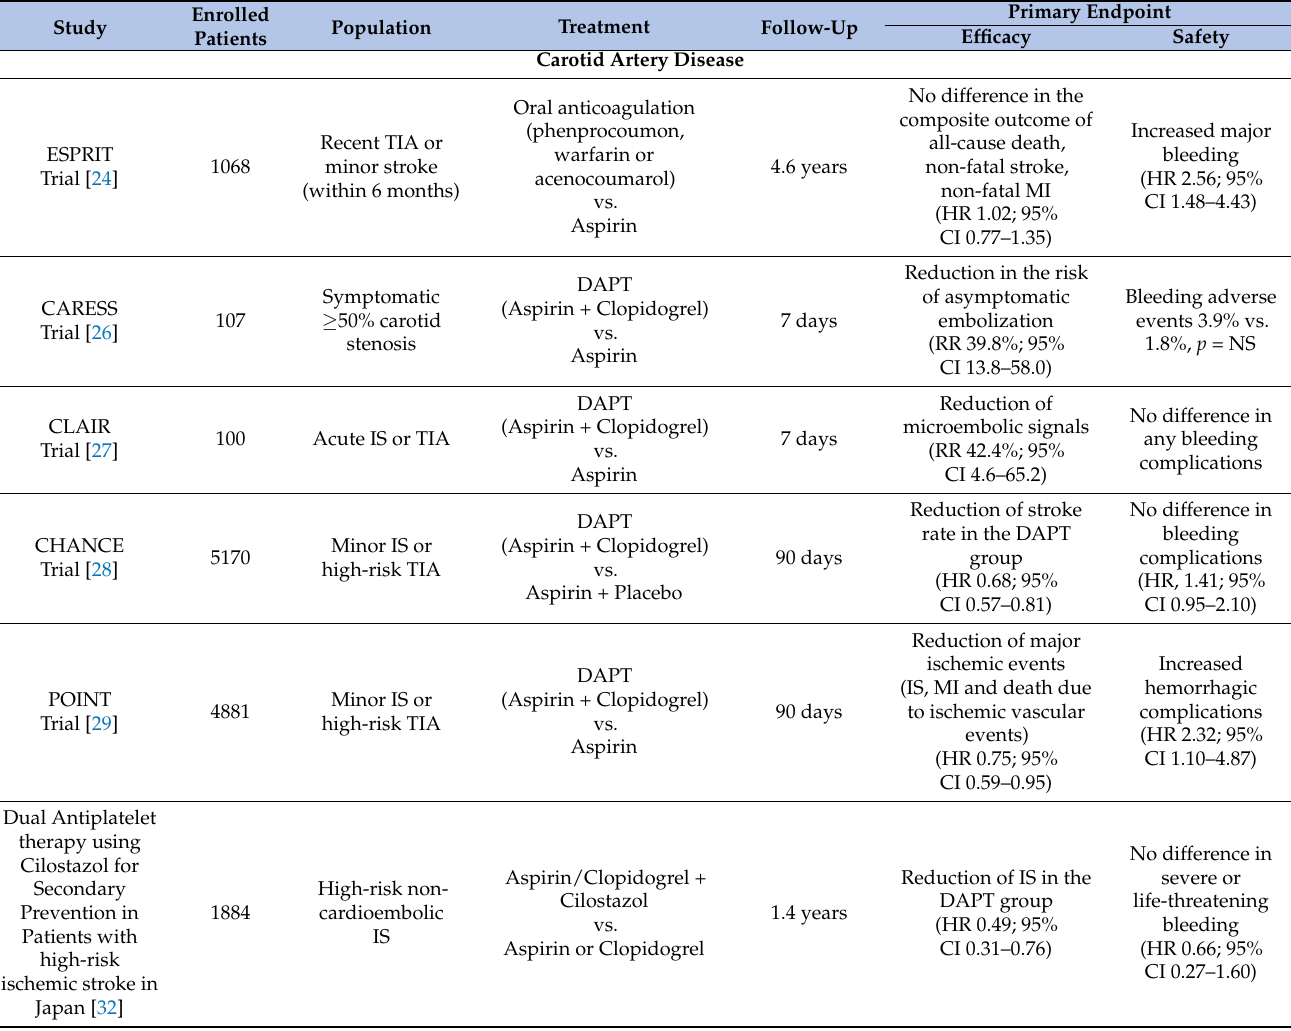
Table 1. Key antithrombotic trials in a primary population with peripheral artery